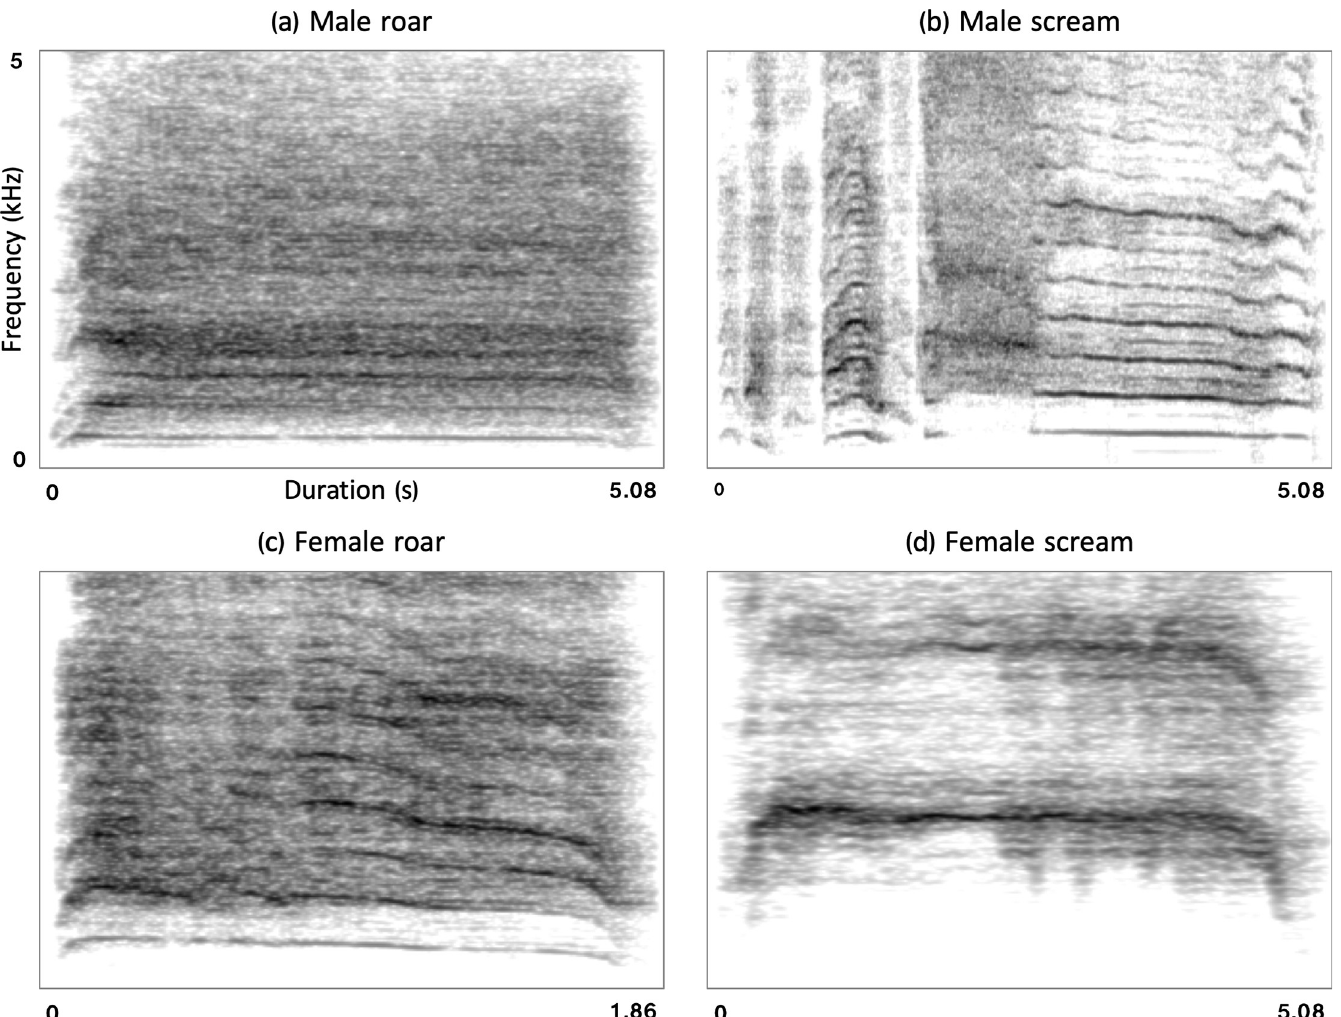
Fig 1. Spectrograms illustrating the acoustic structure of a typical (a) male roar, (b) male scream, (c) female roar, and (d) female scream. Note the higher F0 and more chaotic spectral structure of roars than screams.